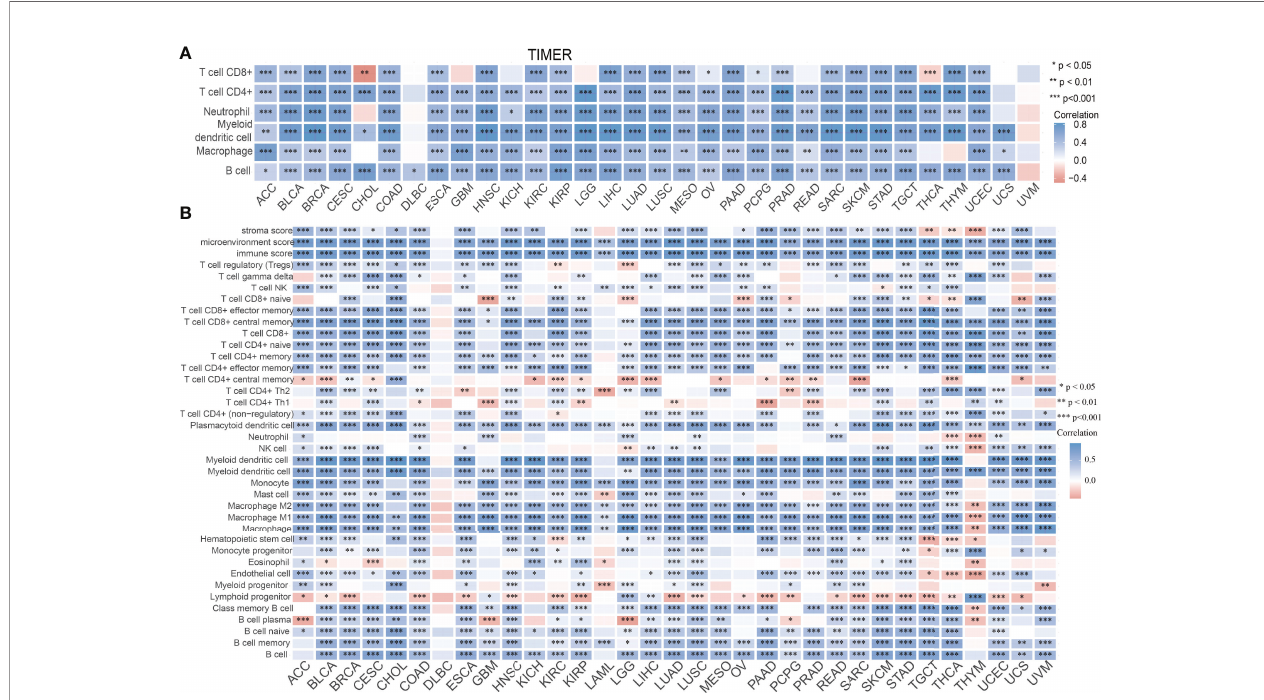
FIGURE 10 | Correlation between SASH3 expression and immune in fi ltrates. (A) Correlations between SASH3 expression and the level of immune in fi ltration in 33 types of human cancer using TIMER. (B) Correlations between SASH3 expression and the level of immune in fi ltration in 33 types of human cancer using xCell. * p < 0.05, ** p < 0.01, *** p <